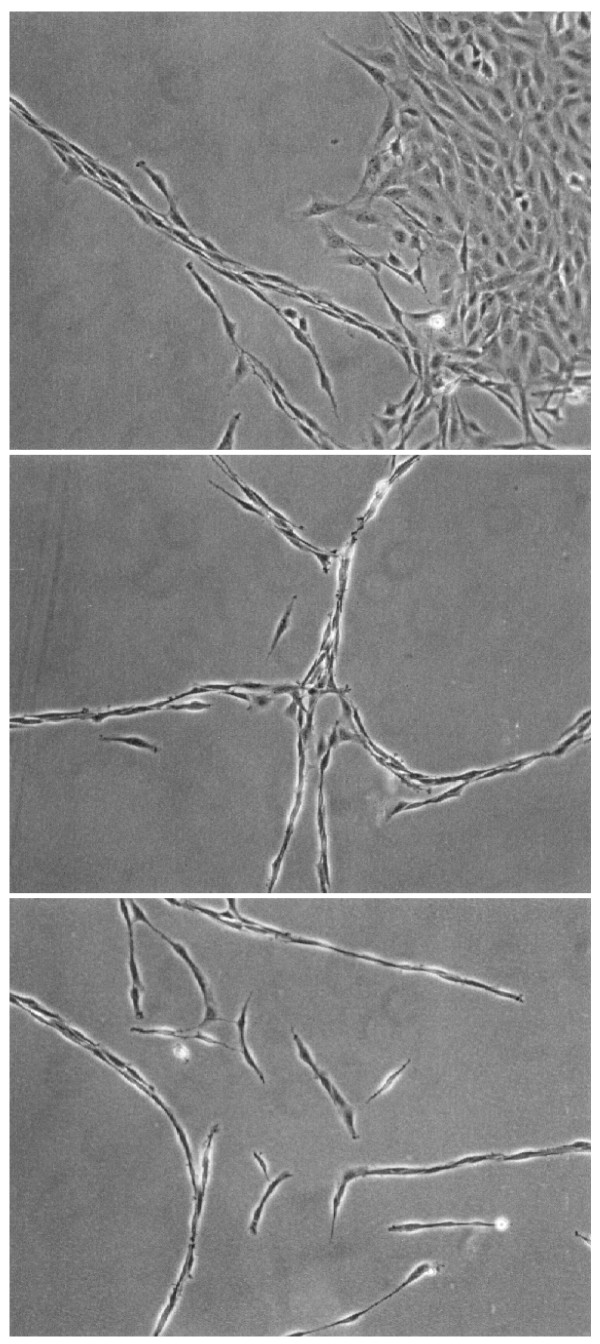
Morphology of 208F/Stk colonies. Cells were seeded 5 days before photographs were taken. See text for descriptions.